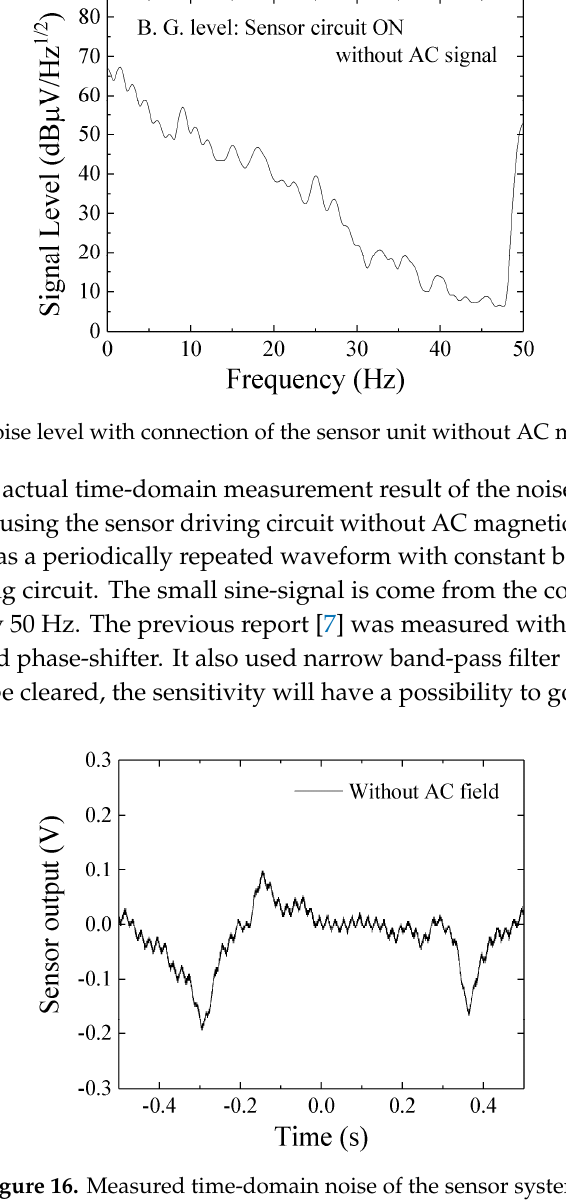
Figure 14. Noise level of measurement apparatus RSA3408A only.